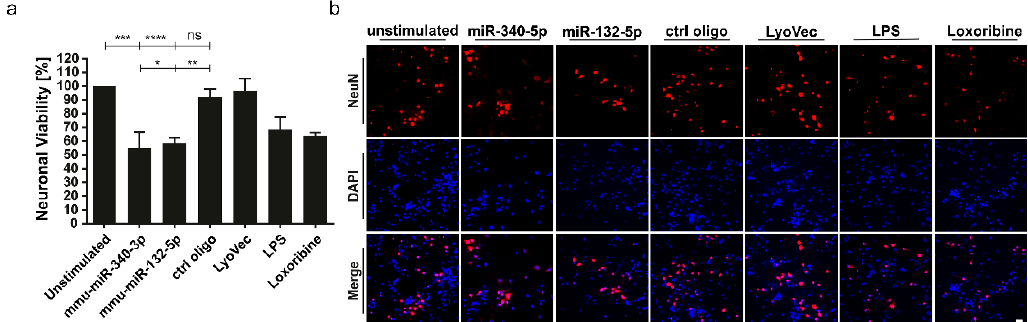
Figure 4. miR-340-3p and miR-132-5p trigger neuronal cell death in co-cultures of neurons and microglia. ( a , b ) Murine neuron / microglia co-cultures derived from C57BL / 6 mice were incubated with 5 µ g / mL of mmu-miR-340-3p, mmu-miR-132-5p, or control mutant oligoribonucleotide (ctrl oligo) for 3 days. LPS (100 ng / mL) and loxoribine (1 mM) were used as positive control, while LyoVec and unstimulated condition served as negative control. Subsequently, cells were stained with NeuN antibody and DAPI. ( a ) Relative neuronal viability was assessed by quantification of NeuN-positive cells.